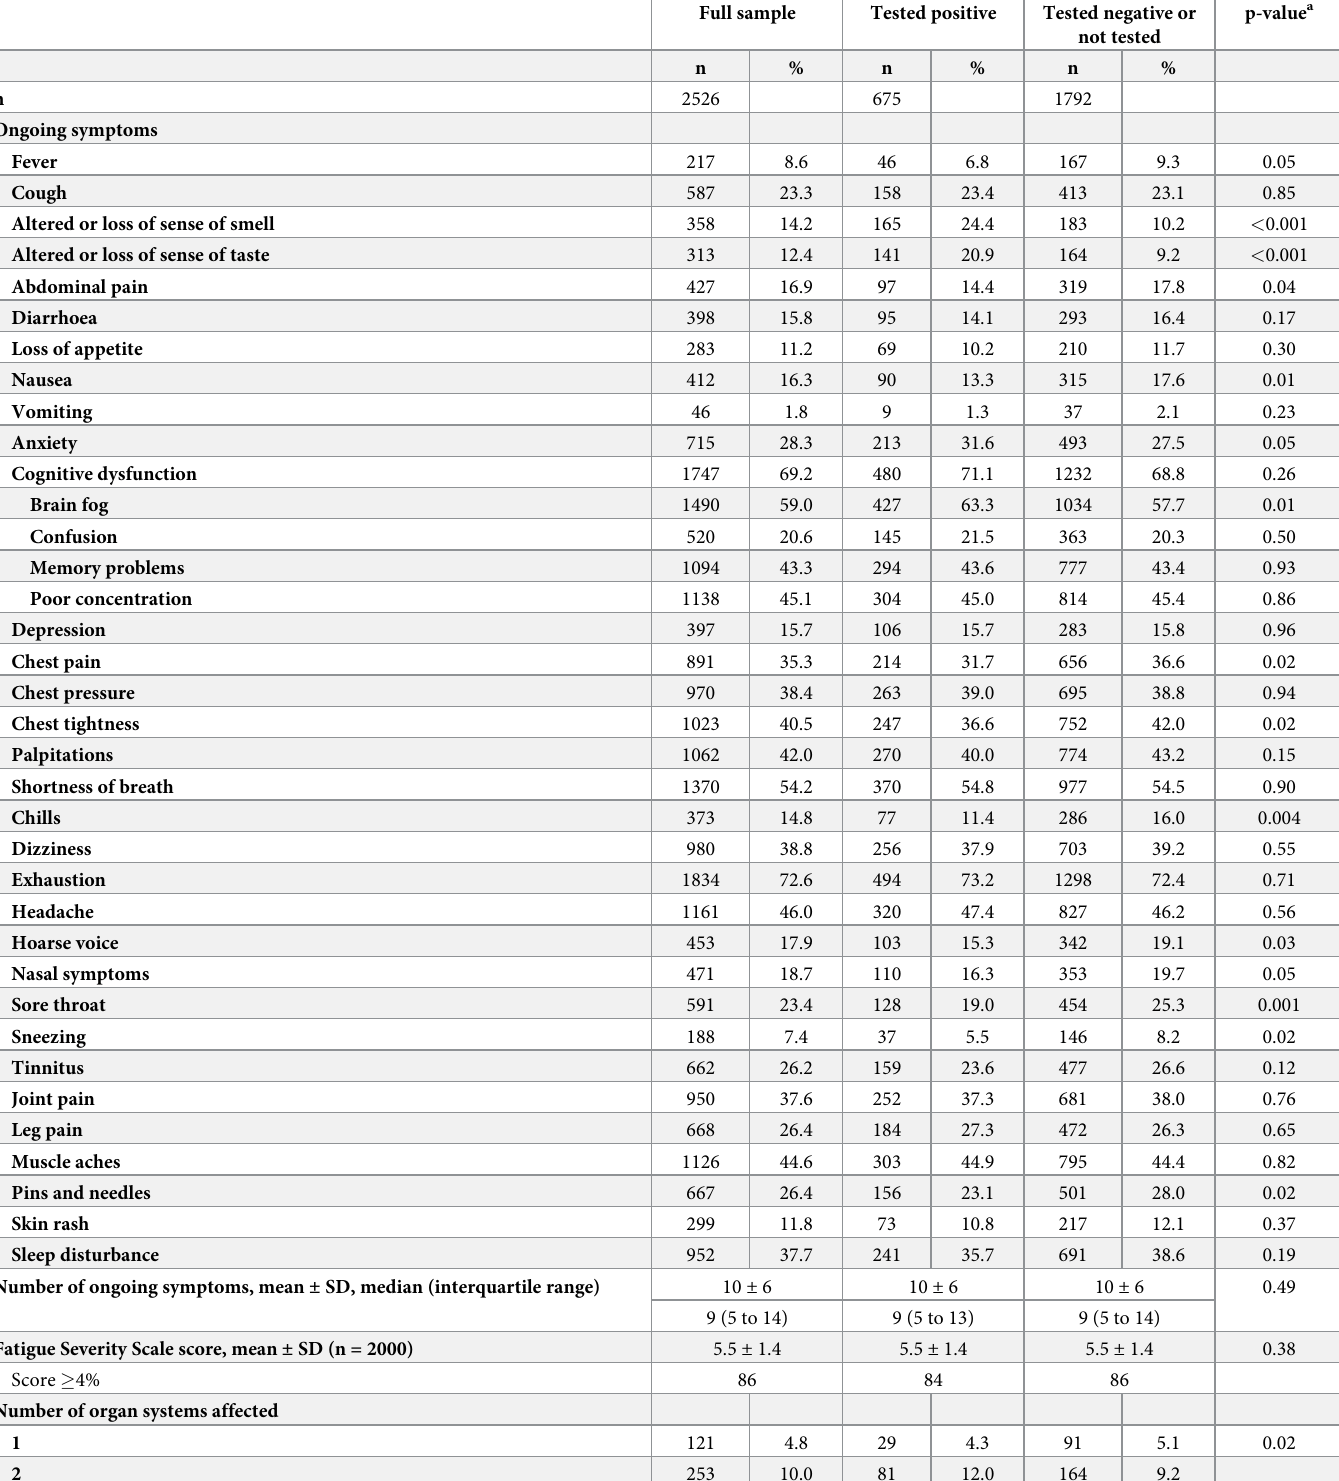
Table 3. Ongoing symptoms, fatigue severity and organ systems affected.